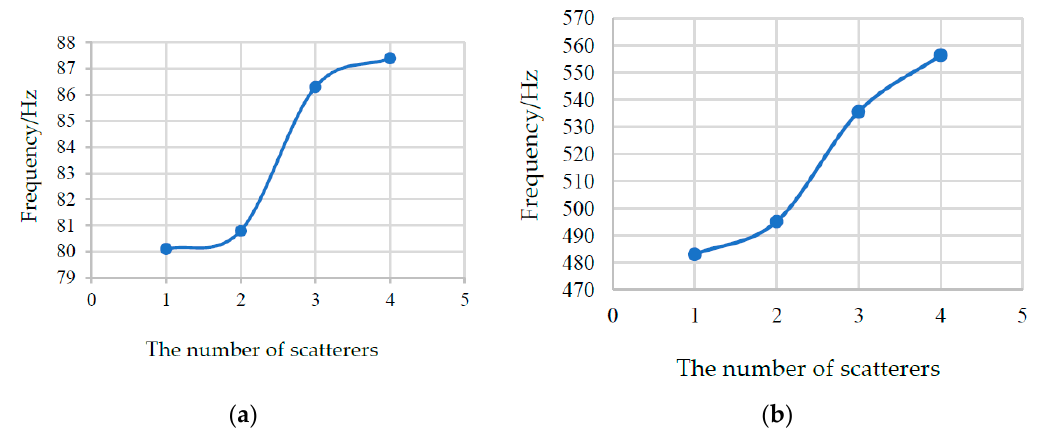
Figure 7. The regular pattern of the starting frequency and the total bandwidth. ( a ) the variation rule of the starting frequency; ( b ) the variation rule of the total bandwidth (four BGs).